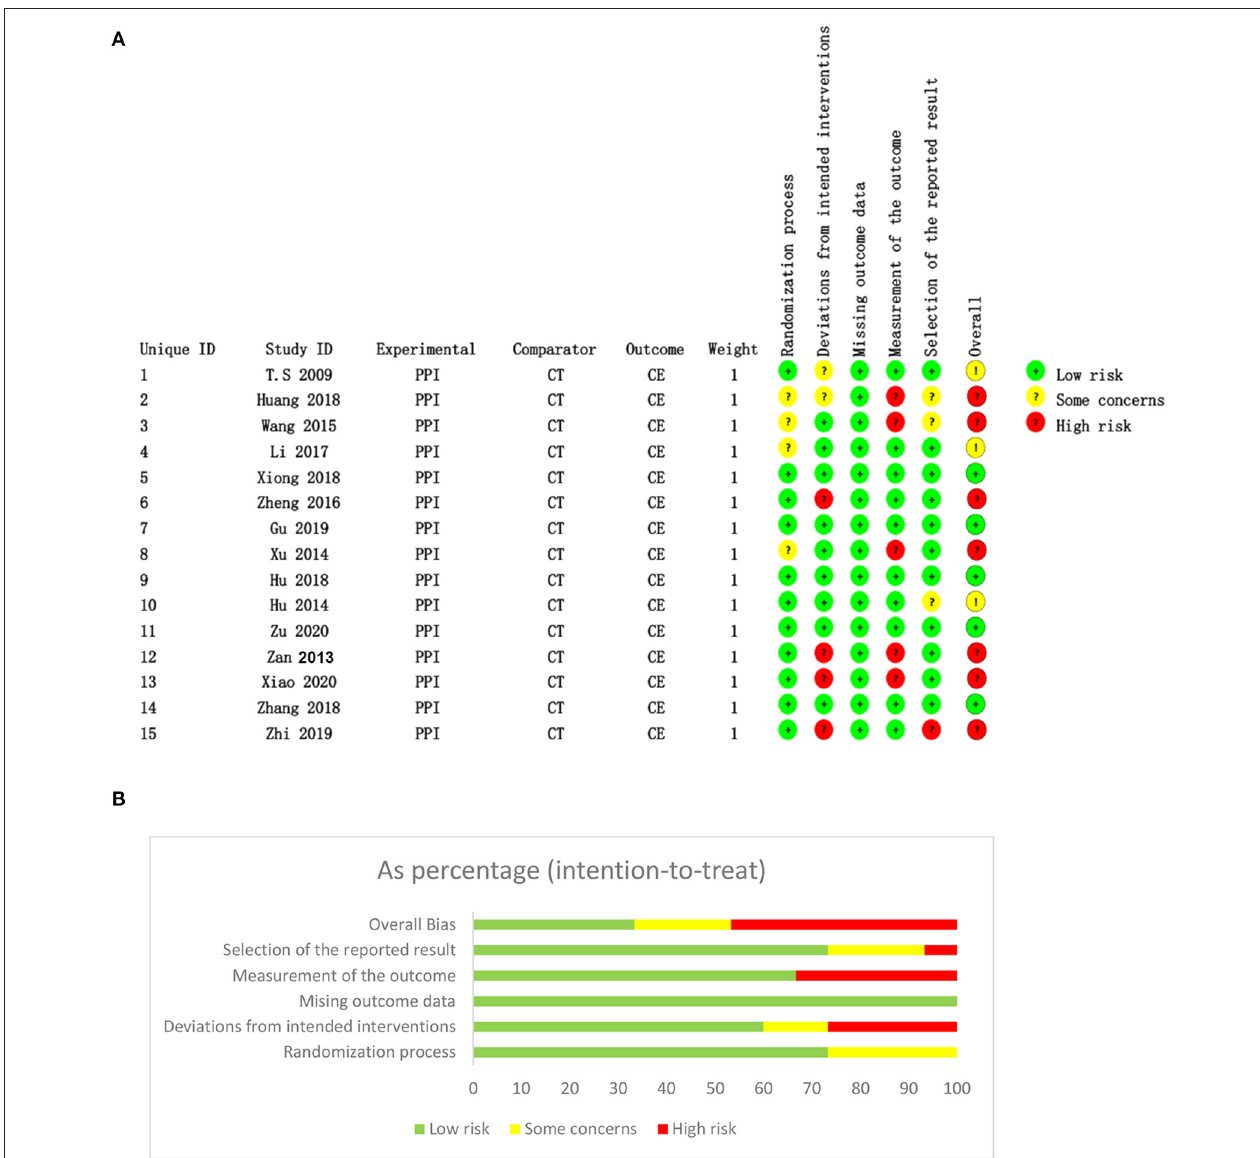
FIGURE 2 | Risks of bias assessed by RoB2 for each included study ( n = 15). (A) Risk of bias graph; (B) risk of bias summary. CT, conventional treatment; CE, clinical